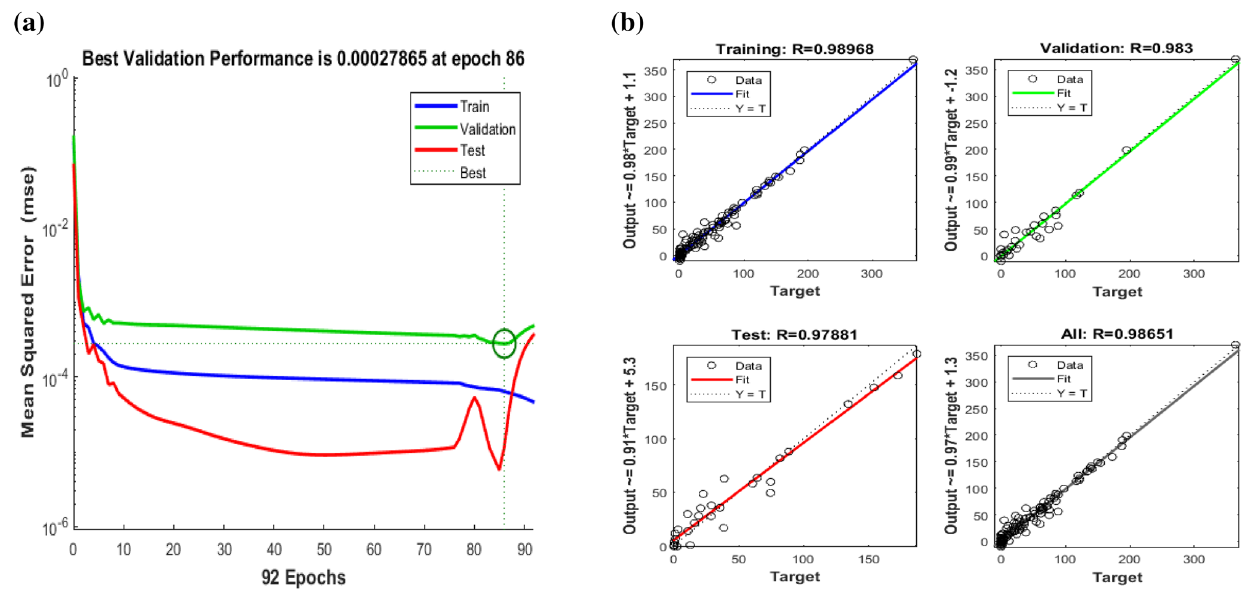
Fig. 12 Performance and regression plot of permeability ANN model